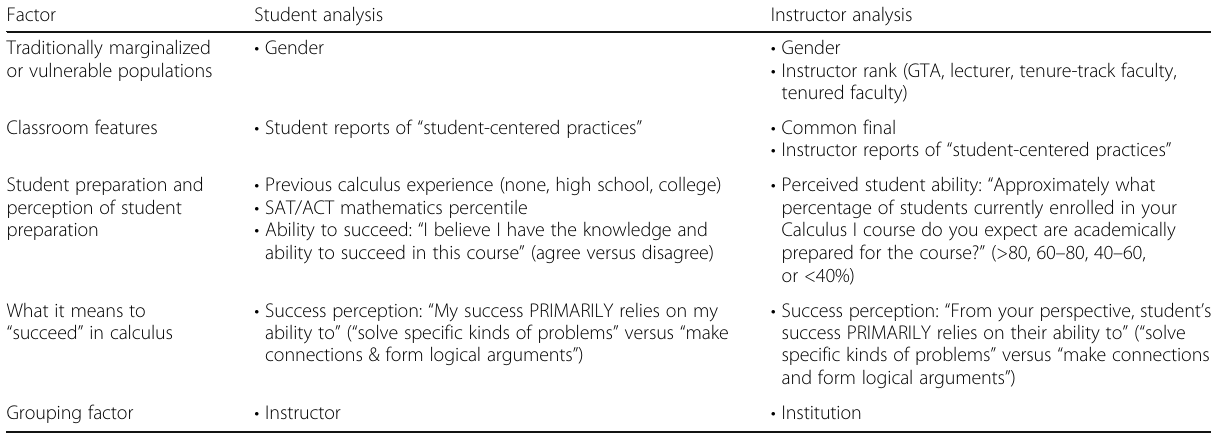
Table 1 Factors and variables used in student and instructor analyses Factor Student